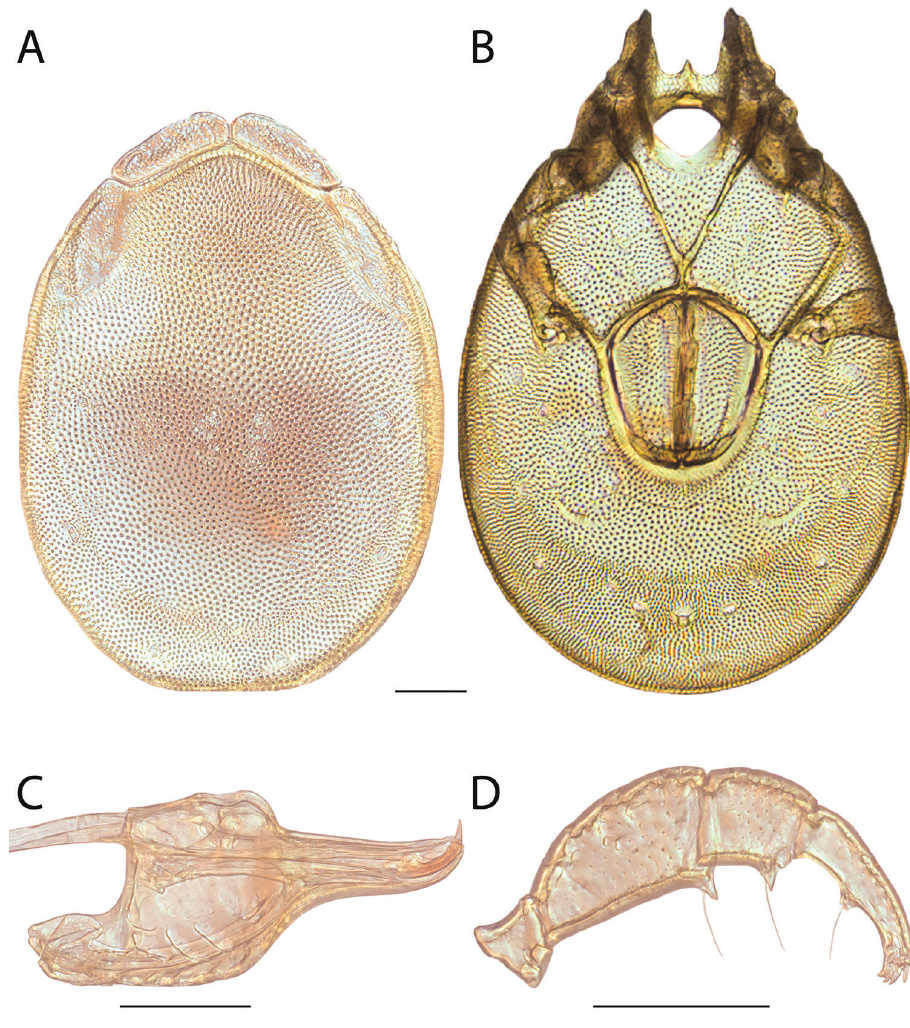
Figure 156. Torrenticola mulleni sp. n. male: A dorsal plates B venter (legs removed) C subcapitulum D pedipalp (setae not accurately depicted). Scale = 100